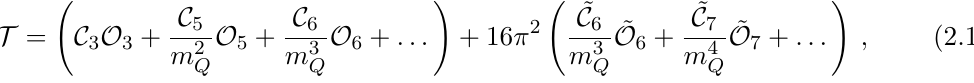
is the QCD scale [16, QCD